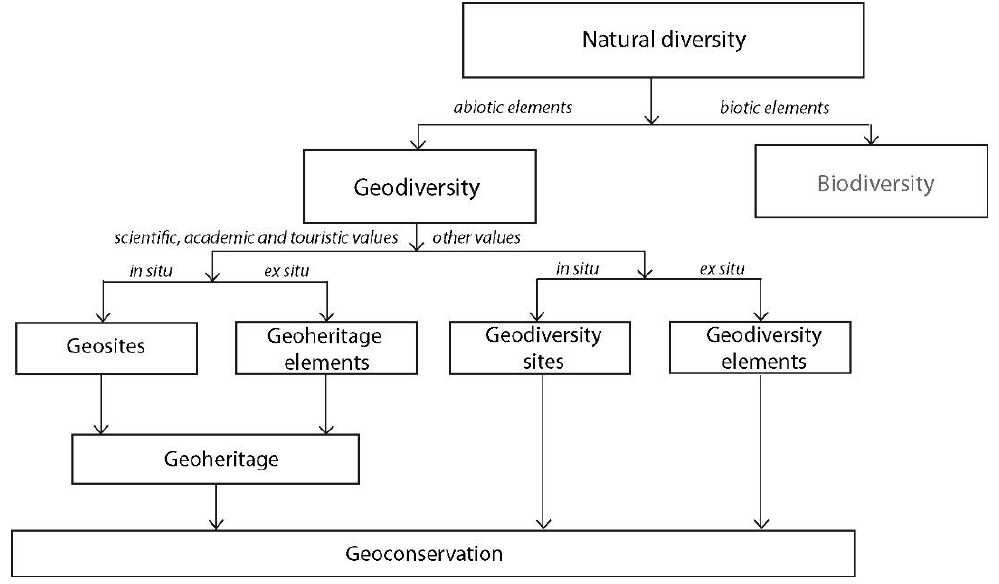
Figure 1. Conceptual framework of geodiversity, geological heritage and geoconservation Modified from [9].